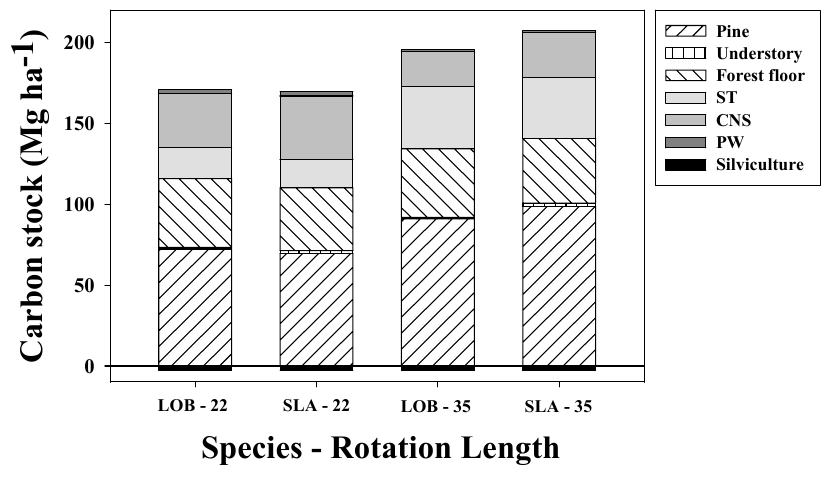
loblolly than in slash pine stands. Figure 8. Average carbon stock for unthinned loblolly (LOB) and slash (SLA) pine plantations for a ~200 year simulation period under two different rotation lengths (22 and 35